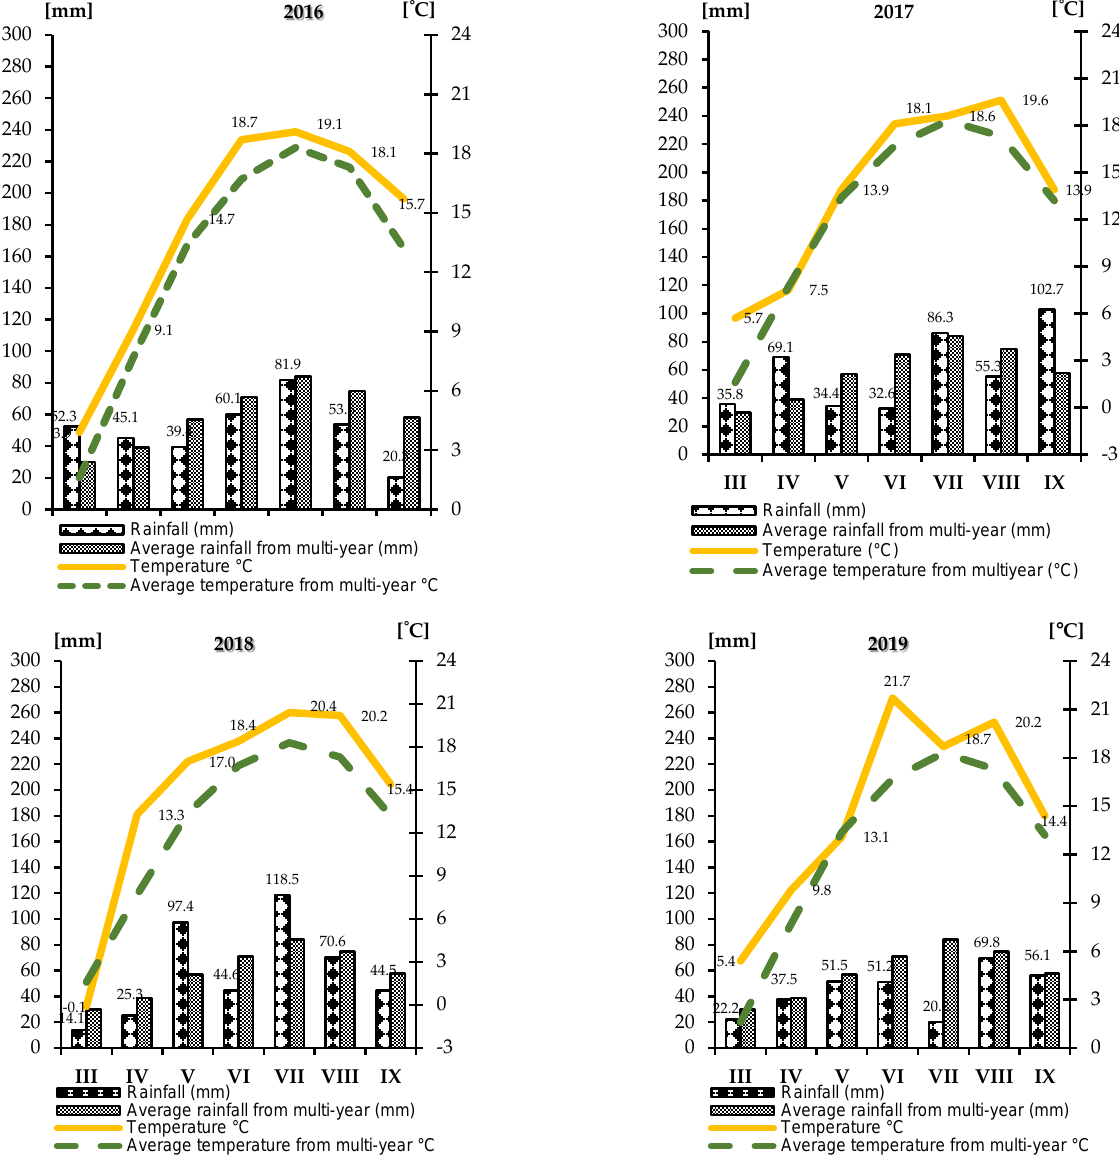
Figure 1. Monthly rainfall and temperature during the growing period from 2016 to 2019, and the long-term (1871 – 2000) average.